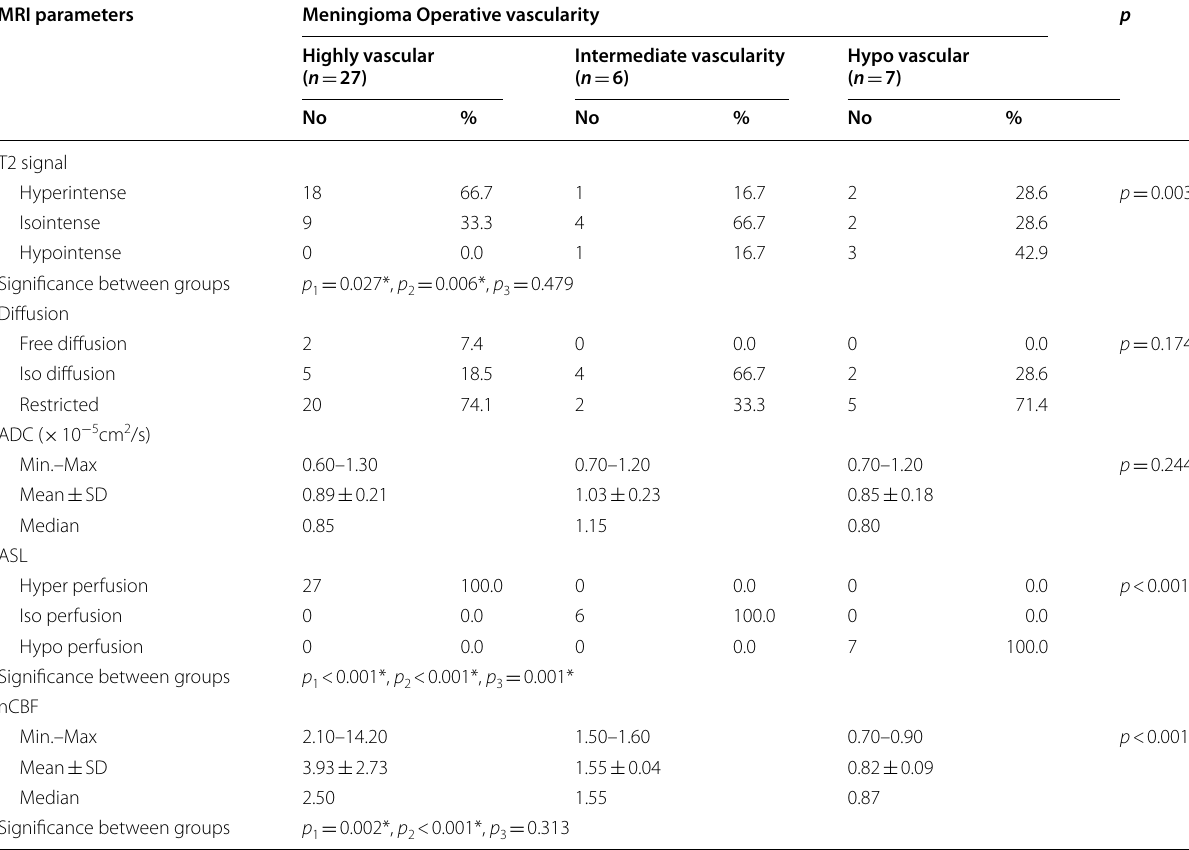
ADC, apparent diffusion coefficient; ASL, arterial spin labeling; n, number of patients; nCBF, normalized cerebral blood flow; p , p value for association between different categories; p 1 , p value for association between hyper vascular and intermediately vascular; p 2 , p value for association between hyper vascular and hypo vascular; p 3 , p value for association between Intermediately vascular and hypo vascular meningioma; SD, standard deviation *Statistically significant at p 0. ≤